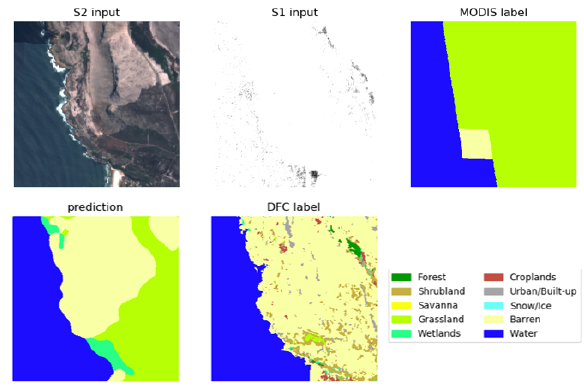
Figure 10: Misclassification of